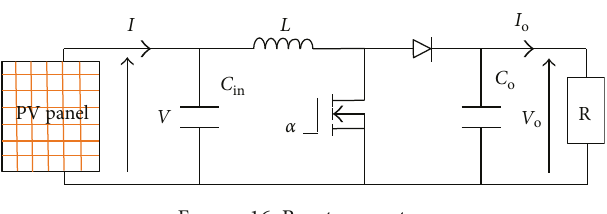
Figure 16: Boost